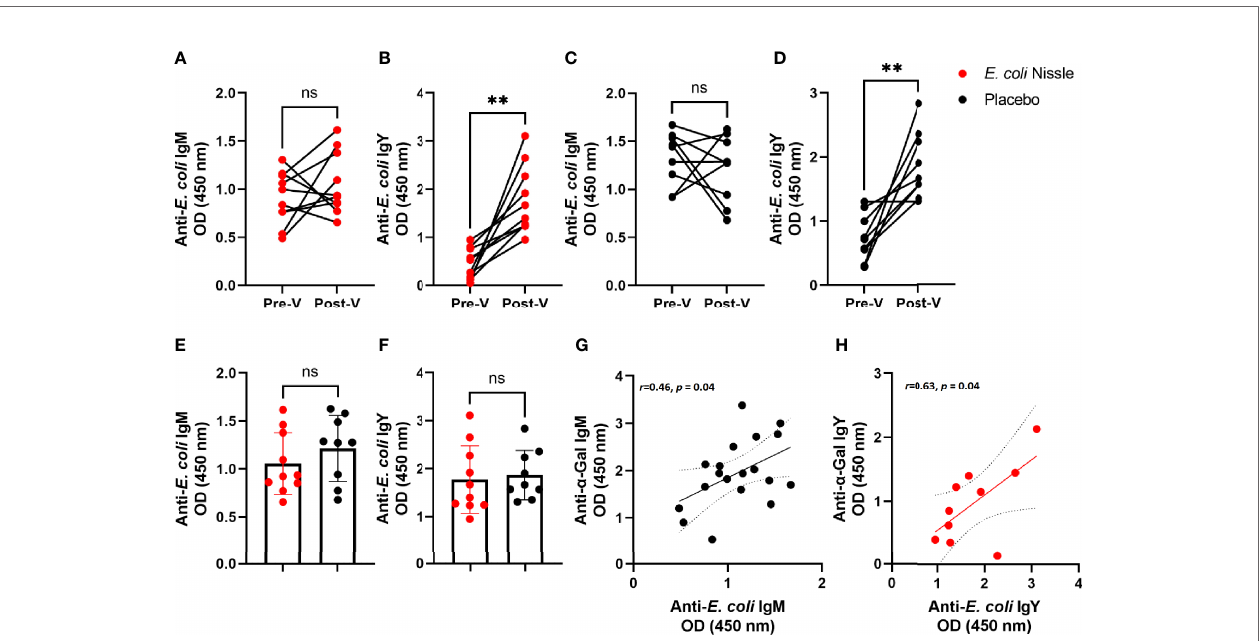
FIGURE 4 | Levels of anti- E. coli Abs after oral administration of E. coli Nissle and their association with anti- a -Gal Ab levels. The levels of anti- E. coli IgM (A, C, E) and IgY (B, D, F) were measured in penguin sera by indirect ELISA in animals of the E. coli Nissle (red dots) and placebo (black dots) groups before (Pre-V) and after (Post-V) the vaccination protocol. No signi fi cant differences were observed in the levels of anti- E. coli IgM within (A, C) and between (E) groups. Signi fi cant differences were observed in the levels of anti- E. coli IgM within (A, C) , but not between (E) groups. Positive correlations between the levels of anti- E. coli IgM and anti- a -Gal IgM Pre-V (Pearson coef fi cient r =0.46, p = 0.04) (G) , and anti- E. coli IgY and anti- a -Gal IgY in the E. coli Nissle group Post-V (Pearson coef fi cient r =0.63, p = 0.04) (H) were found. Individual (A – H) and means and standard deviation (E, F) values are shown. Values were compared by paired (A – D) or unpaired (E, F) student ’ s t -test (** p < 0.005; ns, not signi fi cant, 1 experiment, n = 10 in the E. coli Nissle group and n = 9 in the placebo group, and three technical replicates per sample, A-F). Values of both groups placebo and E. coli Nissle were merged for the Pre-V anti- E. coli -anti- a -Gal IgM correlation analysis (n = 19). For the correlation of anti- E. coli -anti- a -Gal E. coli Nissle Post-V IgY n =